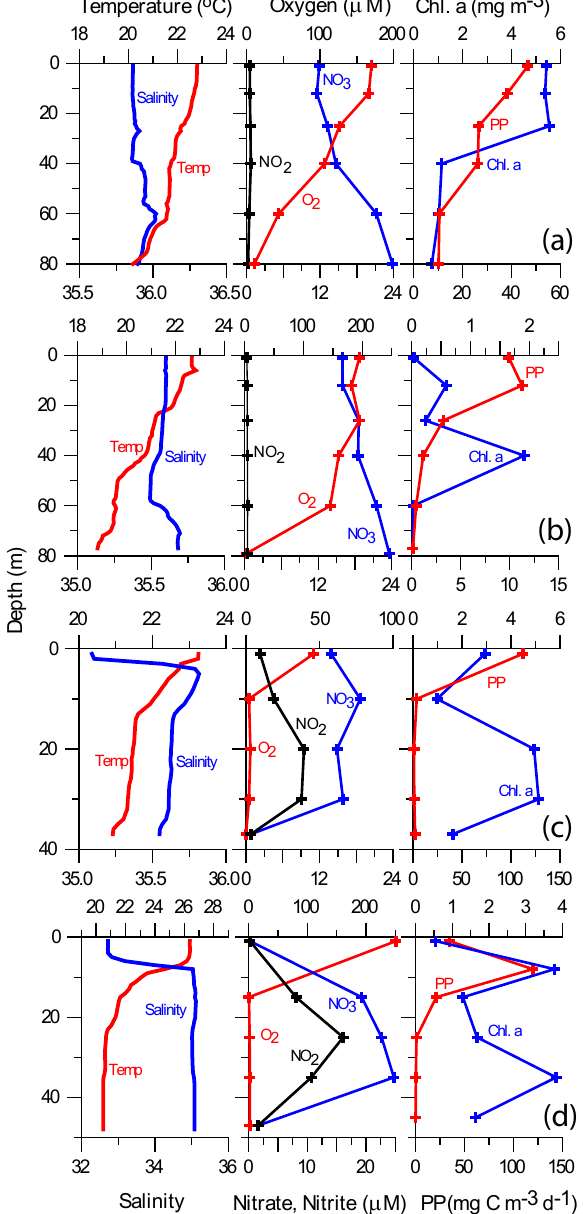
Fig. 5. Vertical profiles of properties at the four stations (two each along the Omani and Indian margins) where primary production (PP) was measured through 14 C incu- bations. The sets of panels starting from the top are for (a) Sta. SK209/07 (22.32 ◦ N, 59.863 ◦ E), (b) Sta. SK209/16 74.613 ◦ E), and (d) Sta. SK208/G06 (15.497 ◦ N, 73.552 ◦ E). Temperature and salinity data from the CTD sensors were bin- averaged for each 1-m interval whereas all other data are from discrete sampling from the same (up)cast. Nitrate values also include